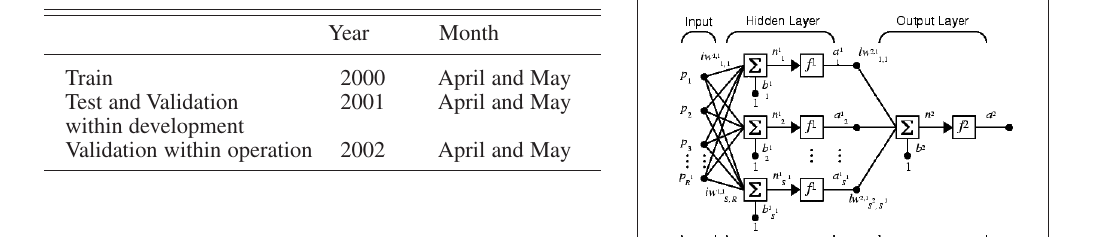
Table 16.I. Selection of the time periods for the input data.